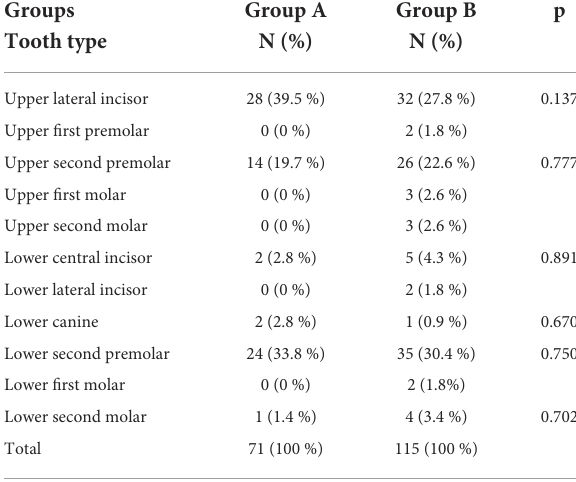
TABLE 5 Distribution of type of missing teeth in upper and lower arches in groups with